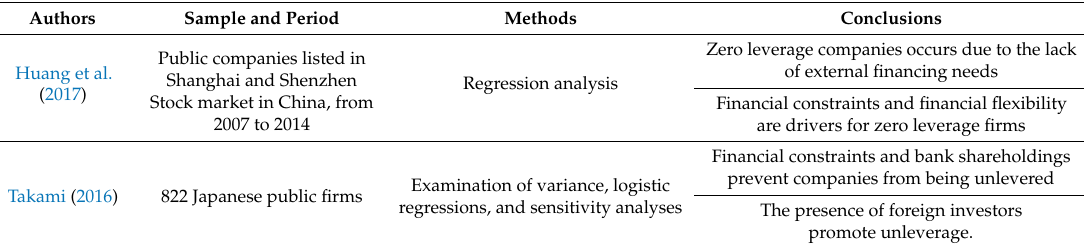
Table 4. Brief review of literature on zero leverage